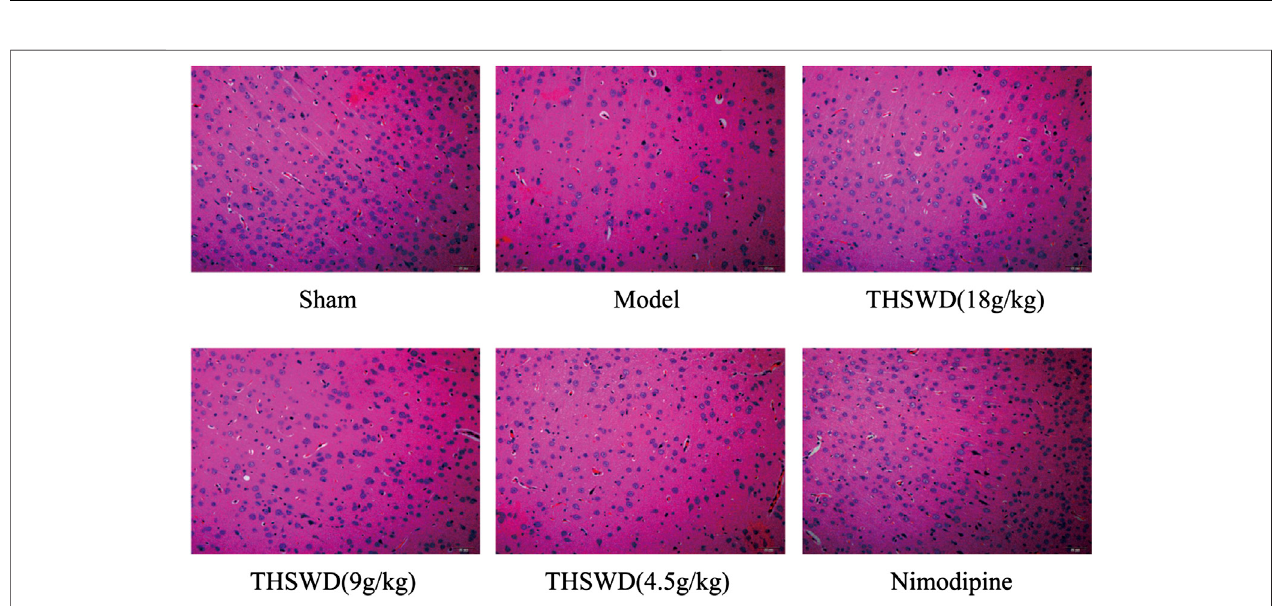
FIGURE 2 | Effect of Taohong Siwu decoction (THSWD) on the level of pathological damage in middle cerebral artery occlusion-reperfusion (MCAO/R) rats ( × 200, n (cid:2) 3).